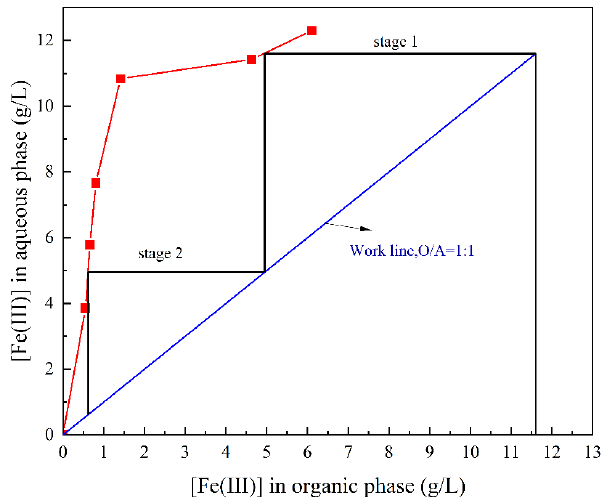
Figure 15. McCabe-Thiele stripping equilibrium isotherms of Fe 3+ on the stripping under the conditions: [oxalic acid] = 1 mol/L, stripping time = 40 min, and stripping temperature = 313 K.